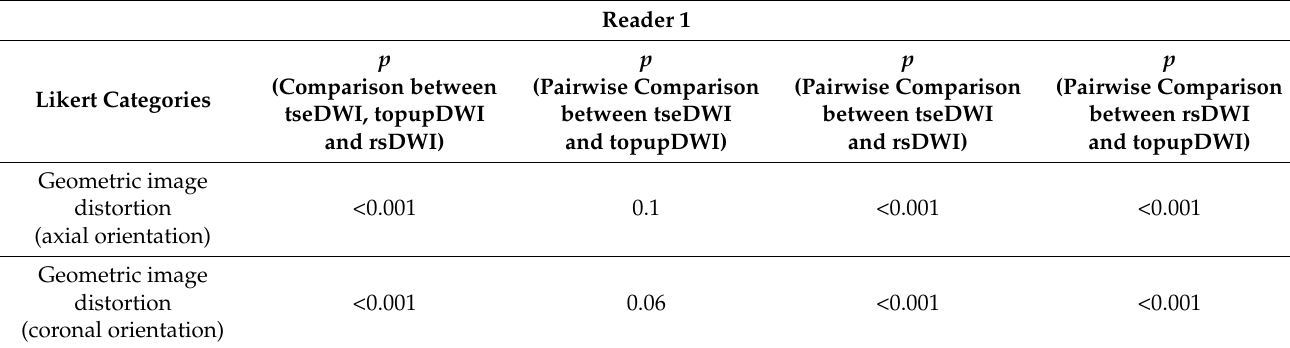
Table 5. Reader-specific comparison between scoring results of evaluation categories 1–5 derived from tseDWI, rsDWI, and topupDWI with pairwise post-hoc